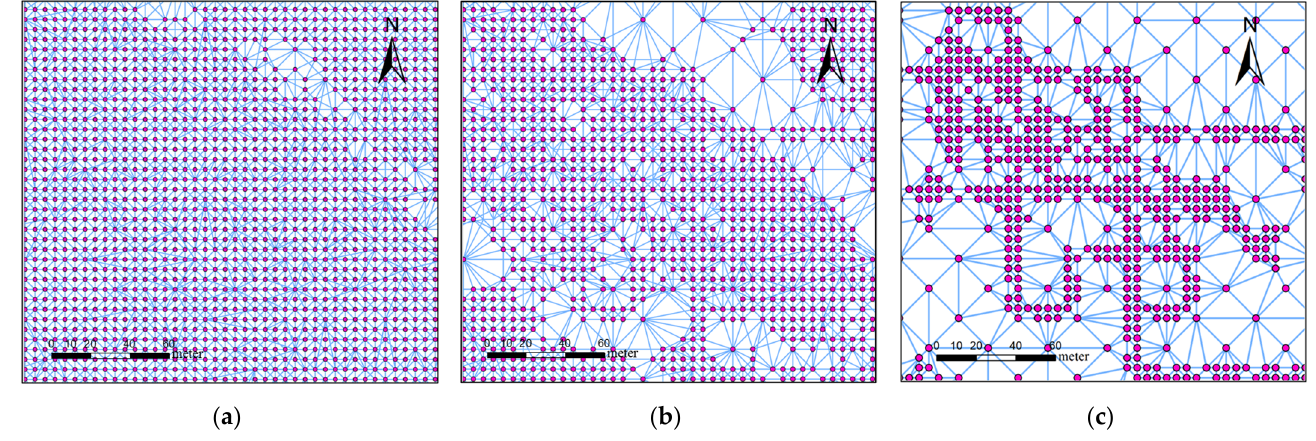
Figure 10. IGN structure with different T ed . ( a ) T ed = 1 m; ( b ) T ed = 3 m; ( c ) T ed = 5